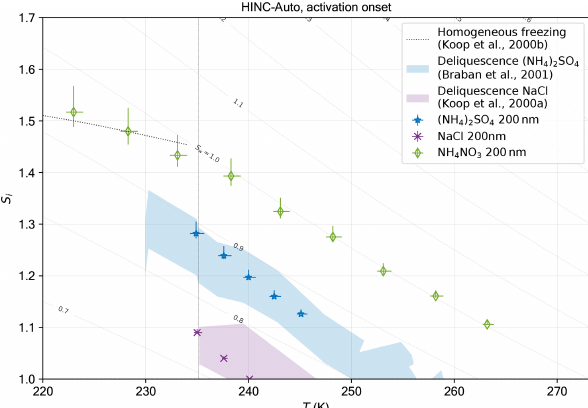
DMA sheath flow of 5 L min − 1 and a higher sample